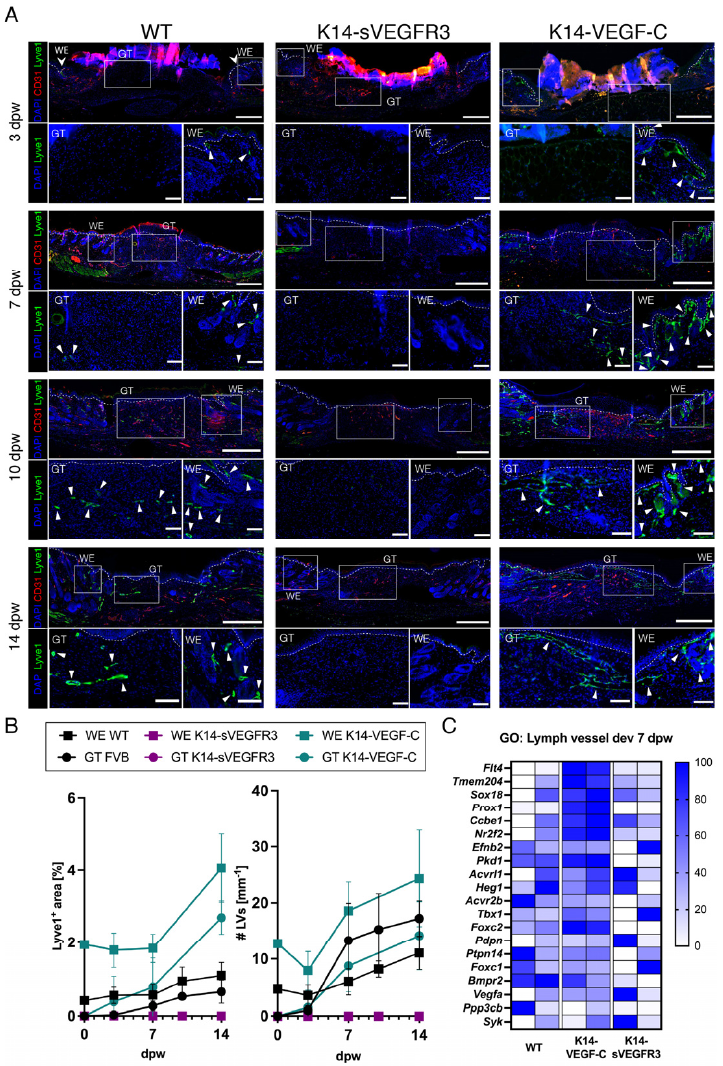
Figure 2. Wound lymphangiogenesis is mediated by the VEGF-C/VEGFR3 signaling axis. ( A ) Rep- resentative LYVE1 and CD31 stained sections of unwounded skin, and wounds at 3-, 7-, 10-, and 14-days post-wounding (dpw) of WT, K14-VEGFR3-Fc, and K14-VEGF-C mice. Scale bars: Overview 500 µ m, GT, WE: 100 µ m. White arrowheads depict LVs. ( B ) LYVE1+ area [%] and the number of LVs divided by the length of BM [mm − 1 ] of WT, K14-VEGFR3-Fc, and K14-VEGF-C mice at 3-, 7-, 10-, and 14-days dpw. N = 3–5 mice per group, 2–3 wounds each. ( C ) Relative gene expression of genes in GO: Lymph vessel development. Gene expression is displayed as a percentage of the expression level of the sample with the highest value for each gene. N = 2 wounds per group. Scale: 0–100%. GT: Granulation tissue, WE: Wound edge, dpw: days